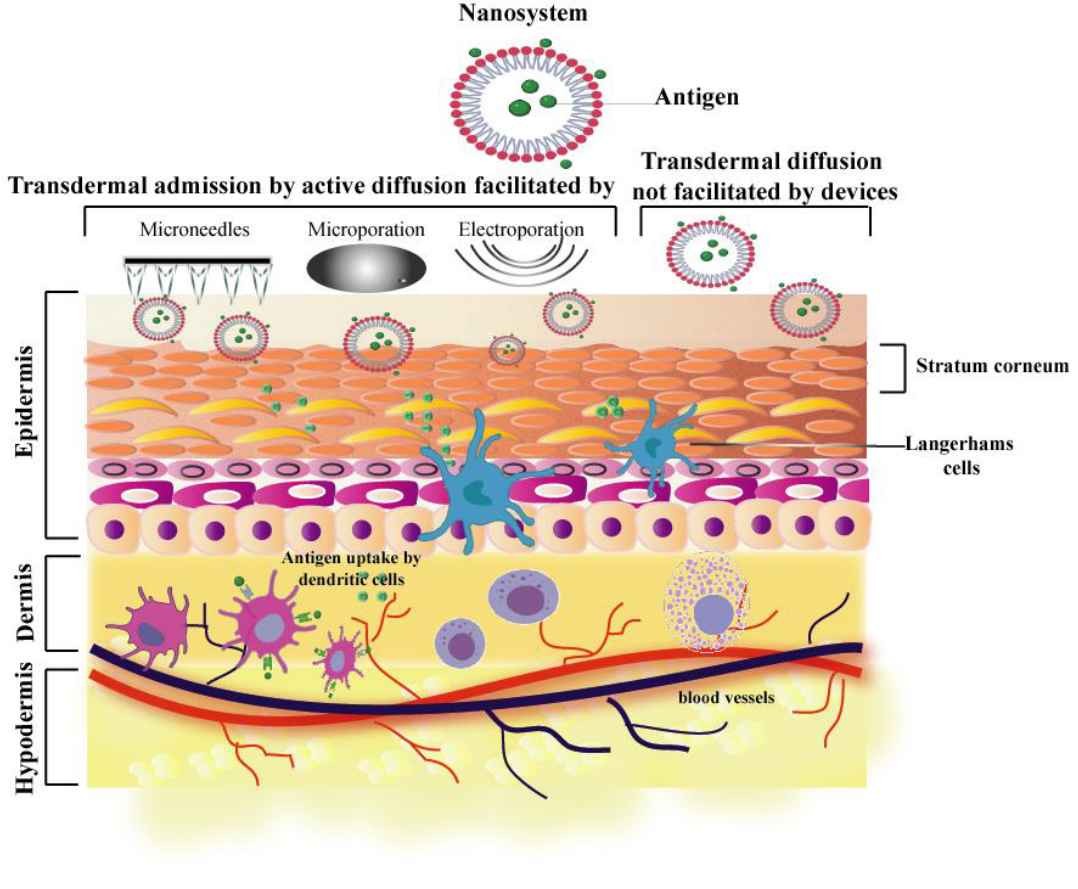
Figure 3. Schematic representation of the mechanisms involved in immunization based on nanoparticles, either using combined techniques or design of nanoparticles by passive diffusion. Once the stratum corneum has been crossed, the antigens can interact with cells of the immune system already described.